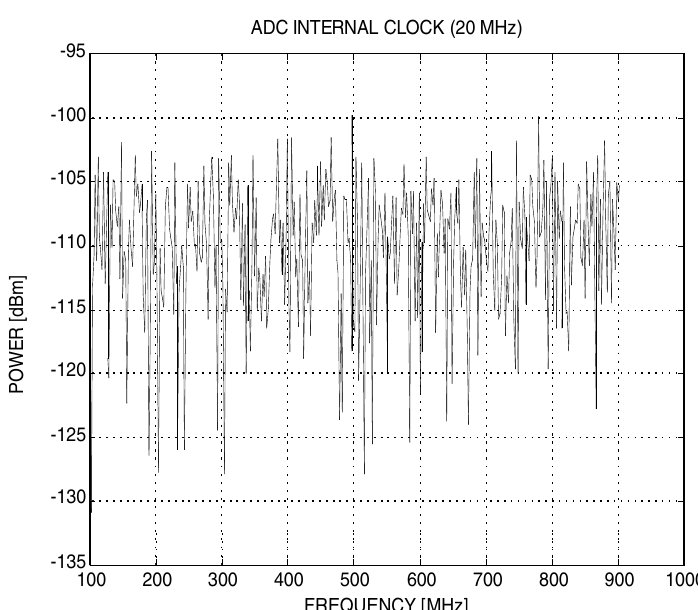
Fig. 3. Noise generated by the clock internal to the